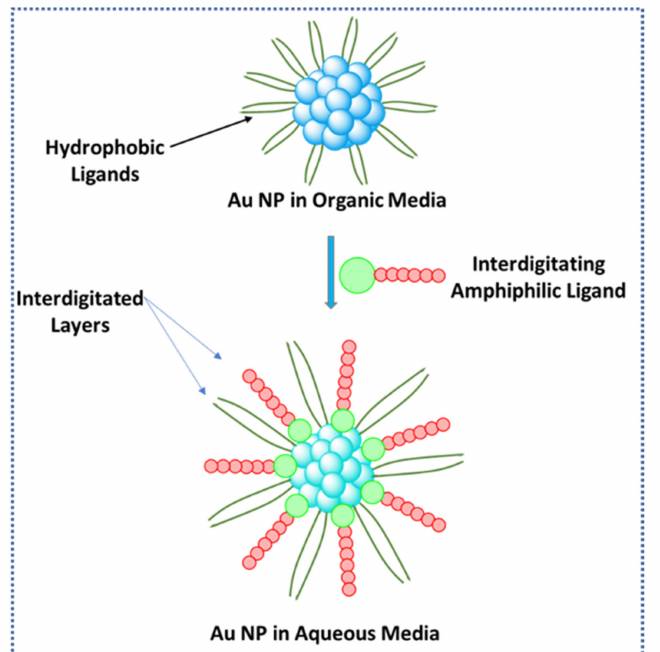
Figure 7. Schematic representation of phase transfer via surface-bound interdigitated layers [7]. Scheme derived from [7]. In the figure, the abbreviation “NP” means